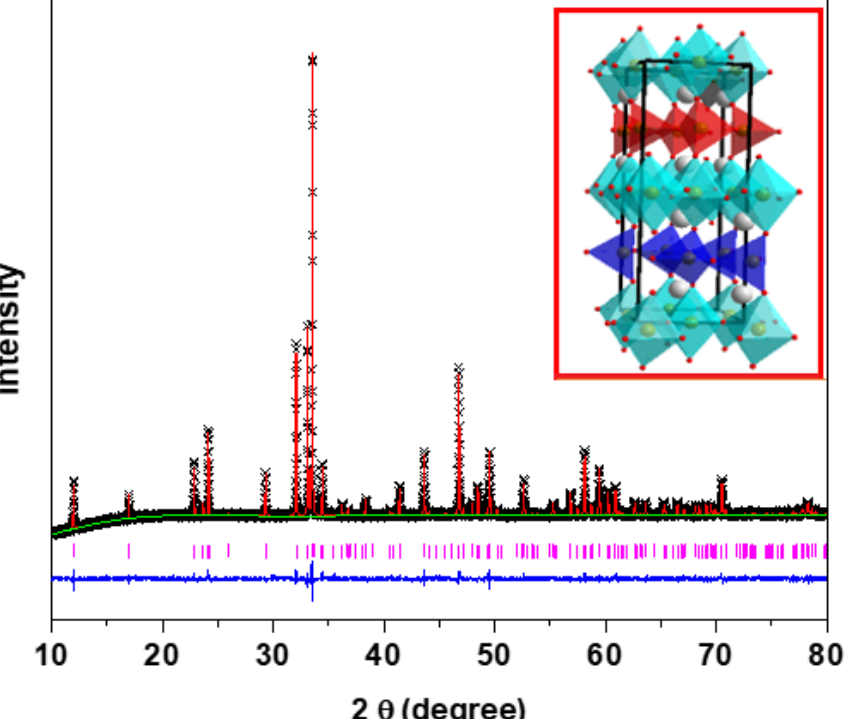
Figure 1. XRD data of Ca 2 Fe 2 O 5 with Rietveld refinement. Crosses and vertical pink tick marks represent experimental data and Bragg peak positions, respectively. The solid red line is the Pnma model, and the lower blue line is the plot difference.